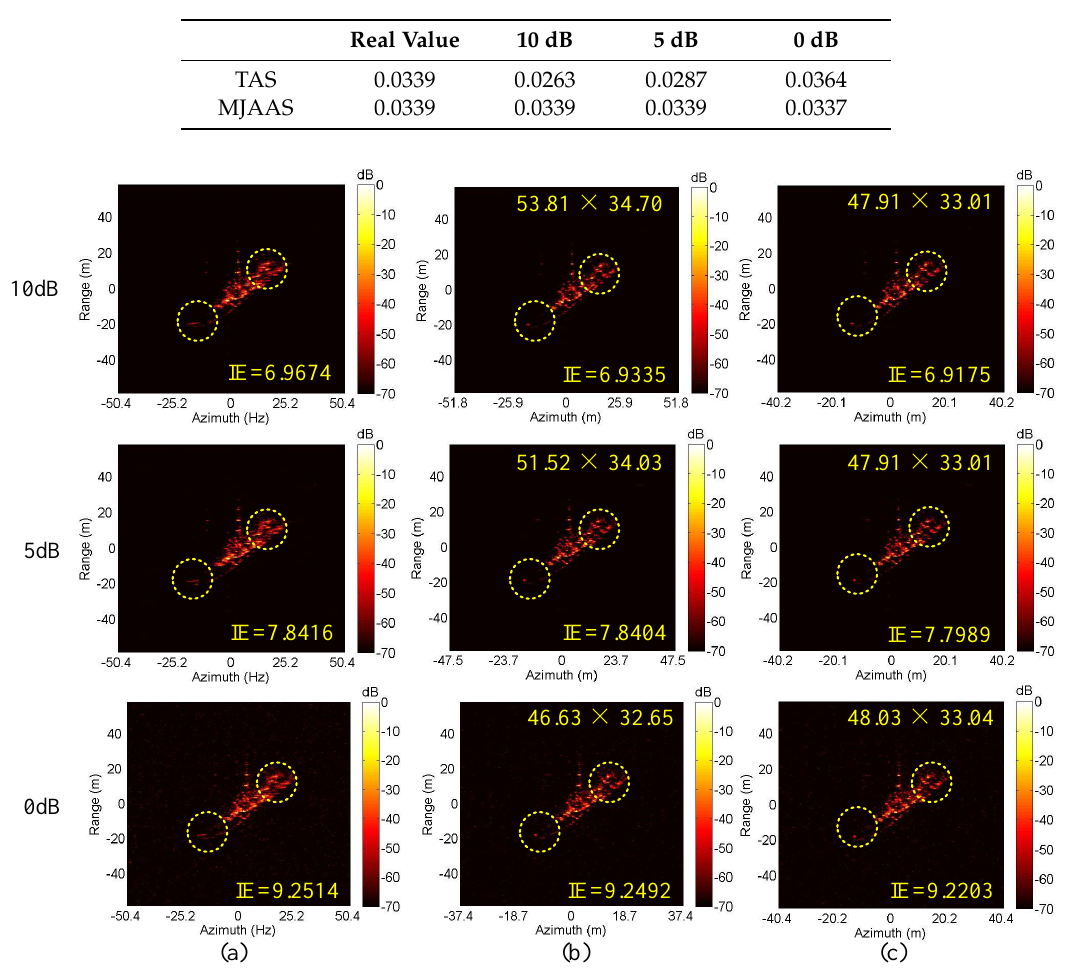
Figure 13. The imaging results of di ff erent algorithms at di ff erent SNRs. ( a ) IMCM-PGA. ( b ) IMCM-PGA-TAS. ( c )